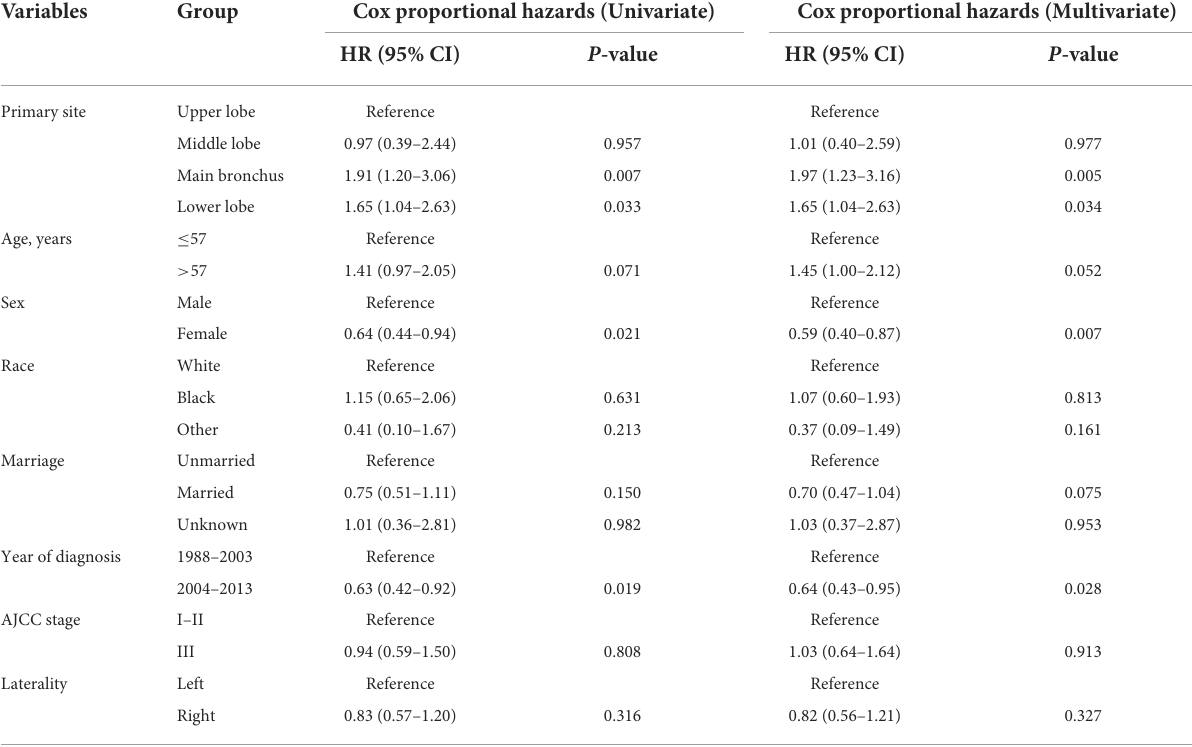
TABLE 2 Cox proportional hazards regression models for predictors of